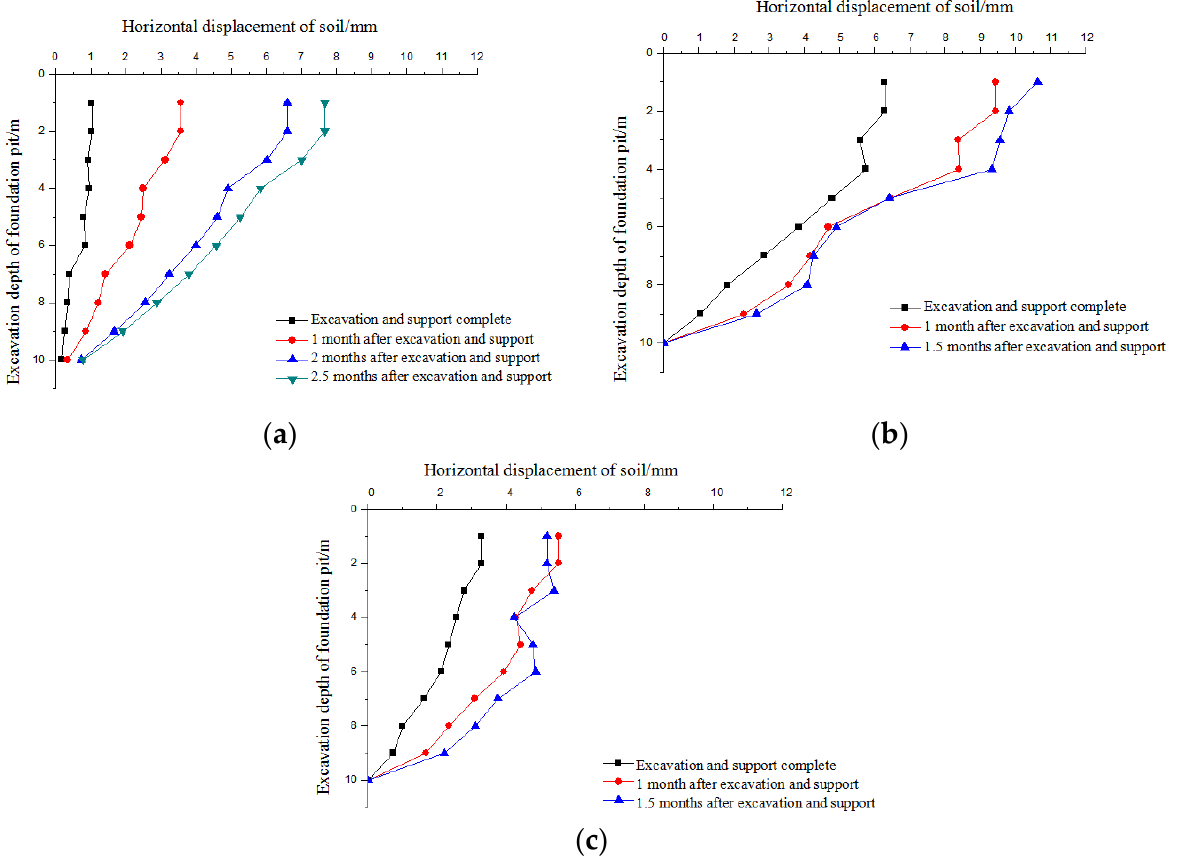
Figure 14. Time history curves for the deformation of No. 5. ( a ) Time history curve for deformation of No. 1 ( b ) Time history curve for deformation of No. 4 ( c ) Time history curve for deformation of No. 5. During the excavation of the foundation pit, the deformation of the foundation pit mainly results from unloading. The increment in earth pressure caused by unloading destroys the original static equilibrium state of the support system, resulting in the dis- placement of the pit wall towards the foundation pit. The deformation of the pit wall mainly depends on two factors, one is the stiffness of the supporting structure itself, and the other is the earth pressure acting on the supporting structure. For soil nailing and prestressed-anchor-composite soil nailing, because there is no vertical advance support, only the concrete surface transmits the earth pressure, and the stiffness of the concrete surface is small. On the premise of meeting the design requirements, the earth pressure applied to the support structure is the main factor affecting the deformation of the sup- porting structure. During the intervals of foundation pit excavation, the properties of the foundation pit are mainly caused by soil consolidation and rheology. Accordingly, in the process of foundation pit excavation, the development of earth pressure goes through two stages. Stage I is a s follows: in the initial stage of excavation, the pit wall undergoes slight deformation under the acting earth pressure. With the passage of time, the deformation of the pit wall increases slowly, the earth pressure on the active side decreases gradually, and the bearing capacity of the soil begins gradually to play a role. When the earth pressure on active side decreases to the minimum, and the static earth pressure σ 0 converts into active earth pressure σ a . Stage II is as follows: in the later stage of excavation, the deformation of the pit wall continues to increase, and the time effect caused by rheology is gradually highlighted, which makes the bearing capacity of the soil begin to decay, leading to a slight increase in the earth pressure on the active side, as shown in Figure